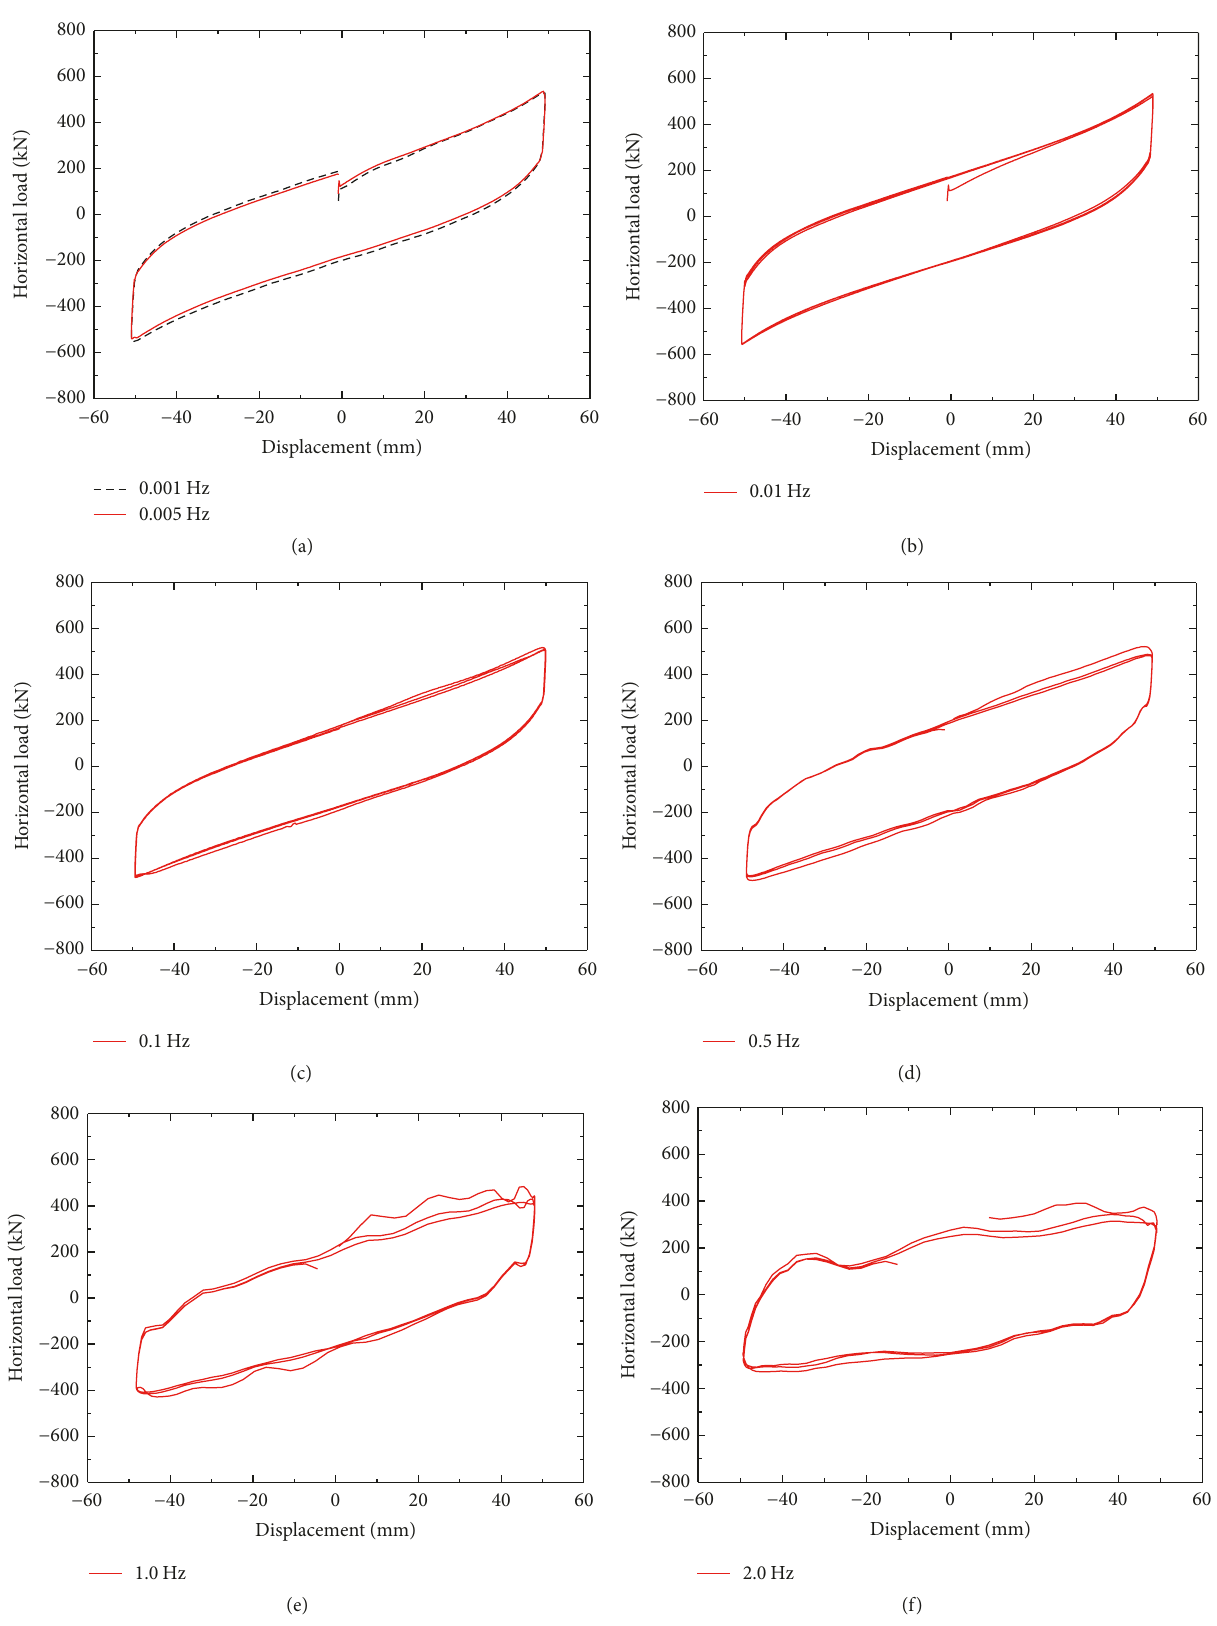
Figure 11: Curves of loading frequency correlation test: (a) 0.001 Hz and 0.005 Hz, (b) 0.01Hz, (c) 0.1Hz, (d) 0.5 Hz, (e) 1.0 Hz, and (f) 2.0